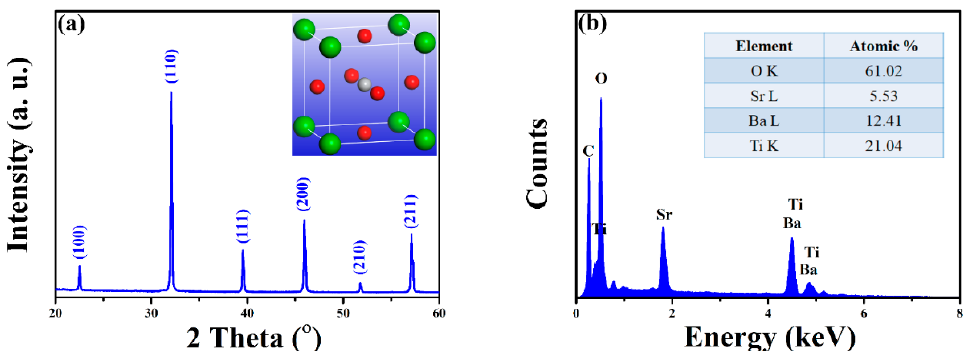
Figure 1. ( a ) XRD pattern of BST thin film. The inset is the perovskite structure with Ti atom (silver) in center, O atom (red) at face, and Ba/Sr atoms (green) at corner. ( b ) EDX spectroscopy of BST films. The inset indicates the atomic percentage of each element.